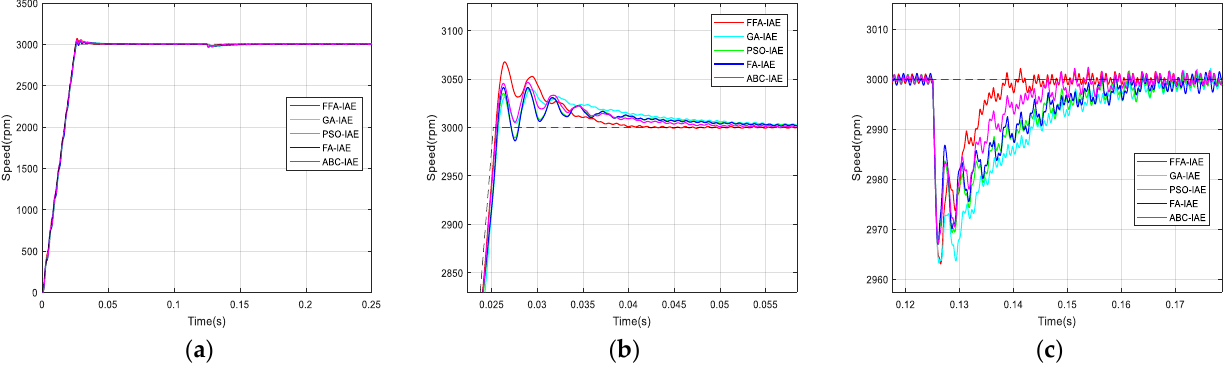
Figure 12. Comparison of speed responses with different algorithms using IAE criterion: ( a ) original; ( b ) and ( c ) zoomed version.